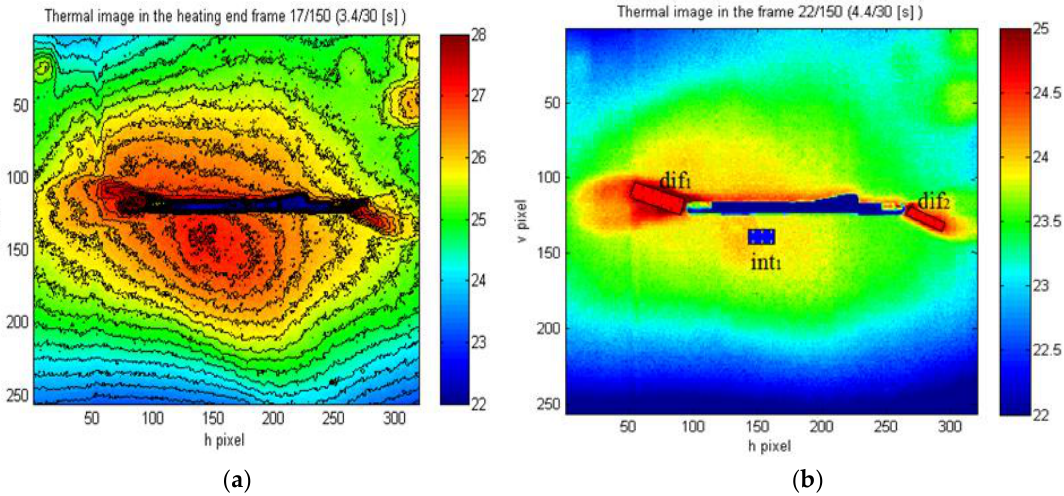
Figure 6. ( a ) Map of isotherm at the beginning of the cooling phase for real component and ( b ) raw thermal image for the central damaged zone of real component using heating time of 7 s.